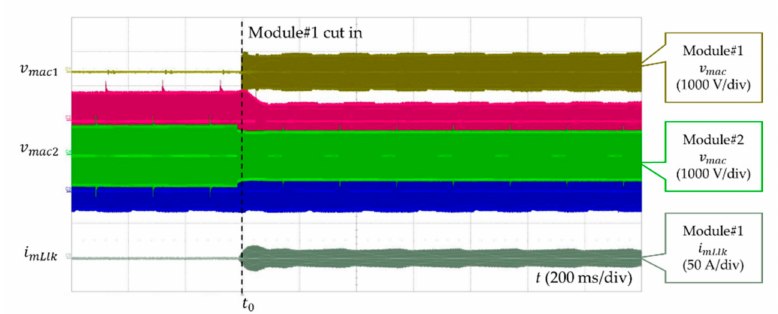
Figure 20. The process of cutting in module online.